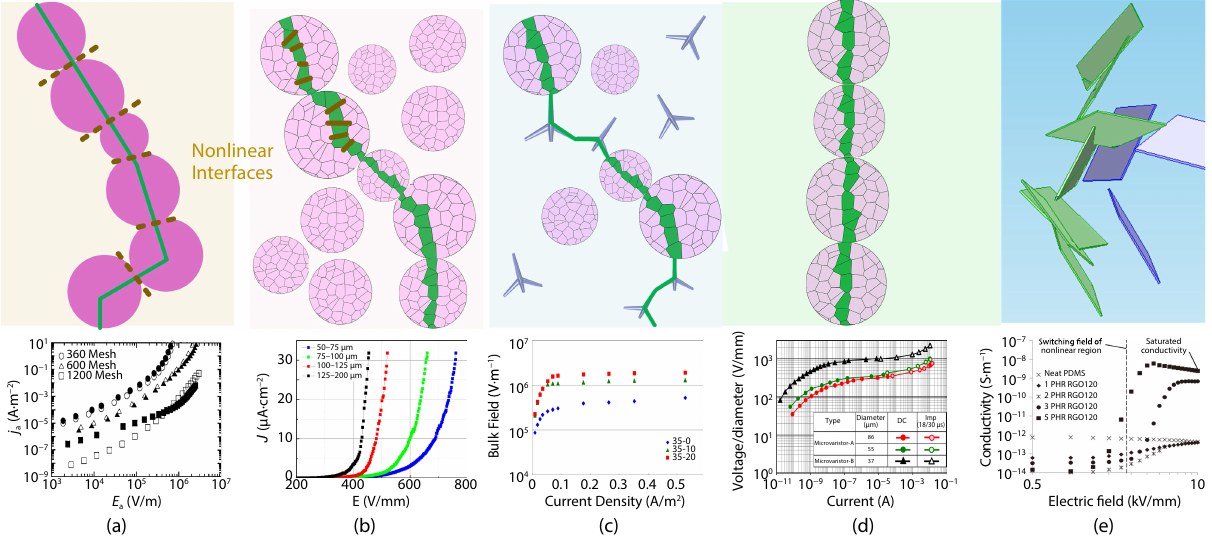
Fig. 3 Schematic diagram and J(E) characteristics of SAD composites with ( a ) SiC (reprinted with permission from ref. [94], © 2001 American Institute of Physics). ( b ) ZnO microvaristor (reprinted with permission from ref. [78], © 2018 IEEE). ( c ) ZnO microvaristor and ZnO whisker (reprinted with permission from ref. [81], © 2012 IEEE). ( d ) Aligned ZnO whiskers (reprinted with permission from ref. [87], © 2014 IEEE). ( e ) GO nonlinear fillers (reprinted with permission